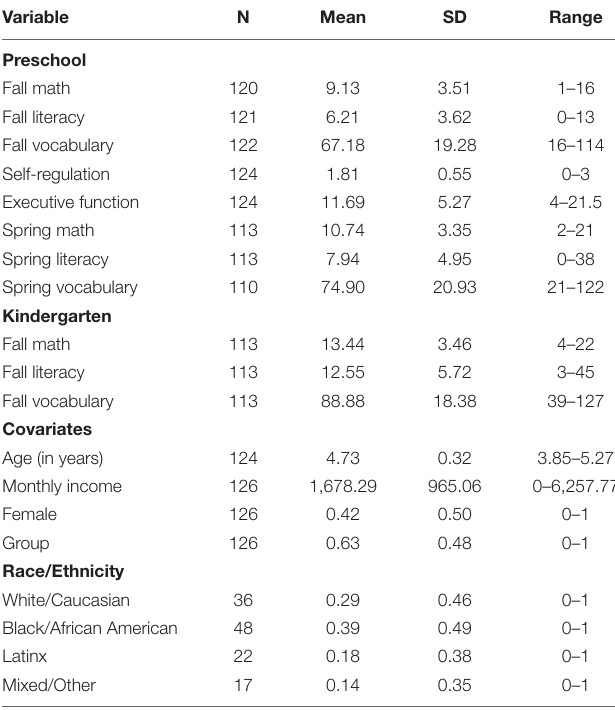
TABLE 1 | Descriptive statistics for sample demographics and primary study variables ( n =